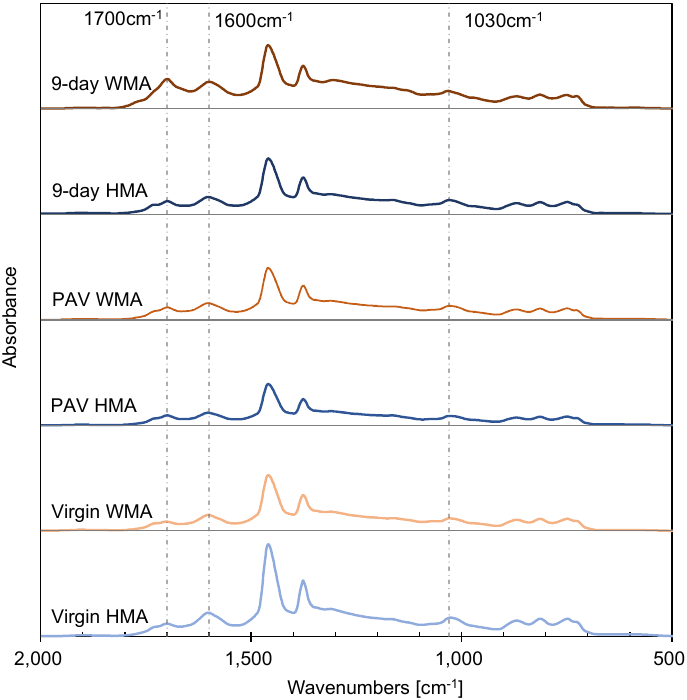
Figure 7. FTIR spectra for the WMA binders before and after ageing.